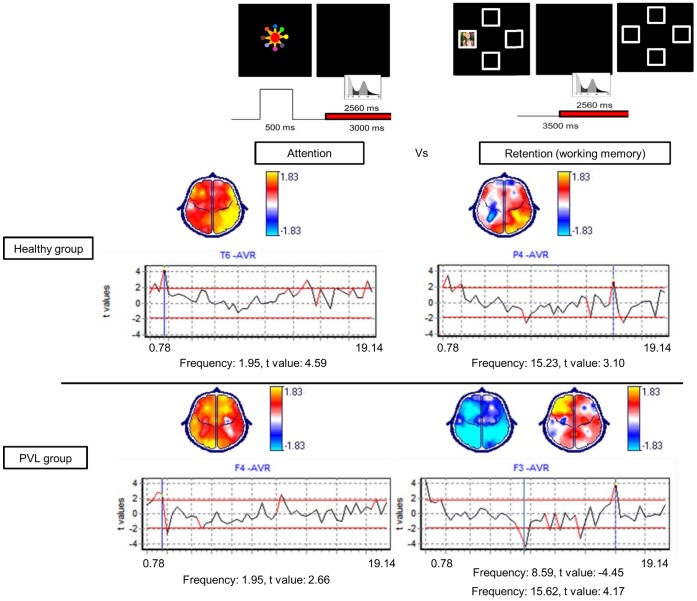
Post-hoc t-test comparing differences between the attention and WM conditions in each group.Positive t values, shown in yellow on the topographic map, imply power increases during WM in comparison with attention. Negative t values, shown in blue on the topographic map, imply power decreases during WM in comparison with attention.